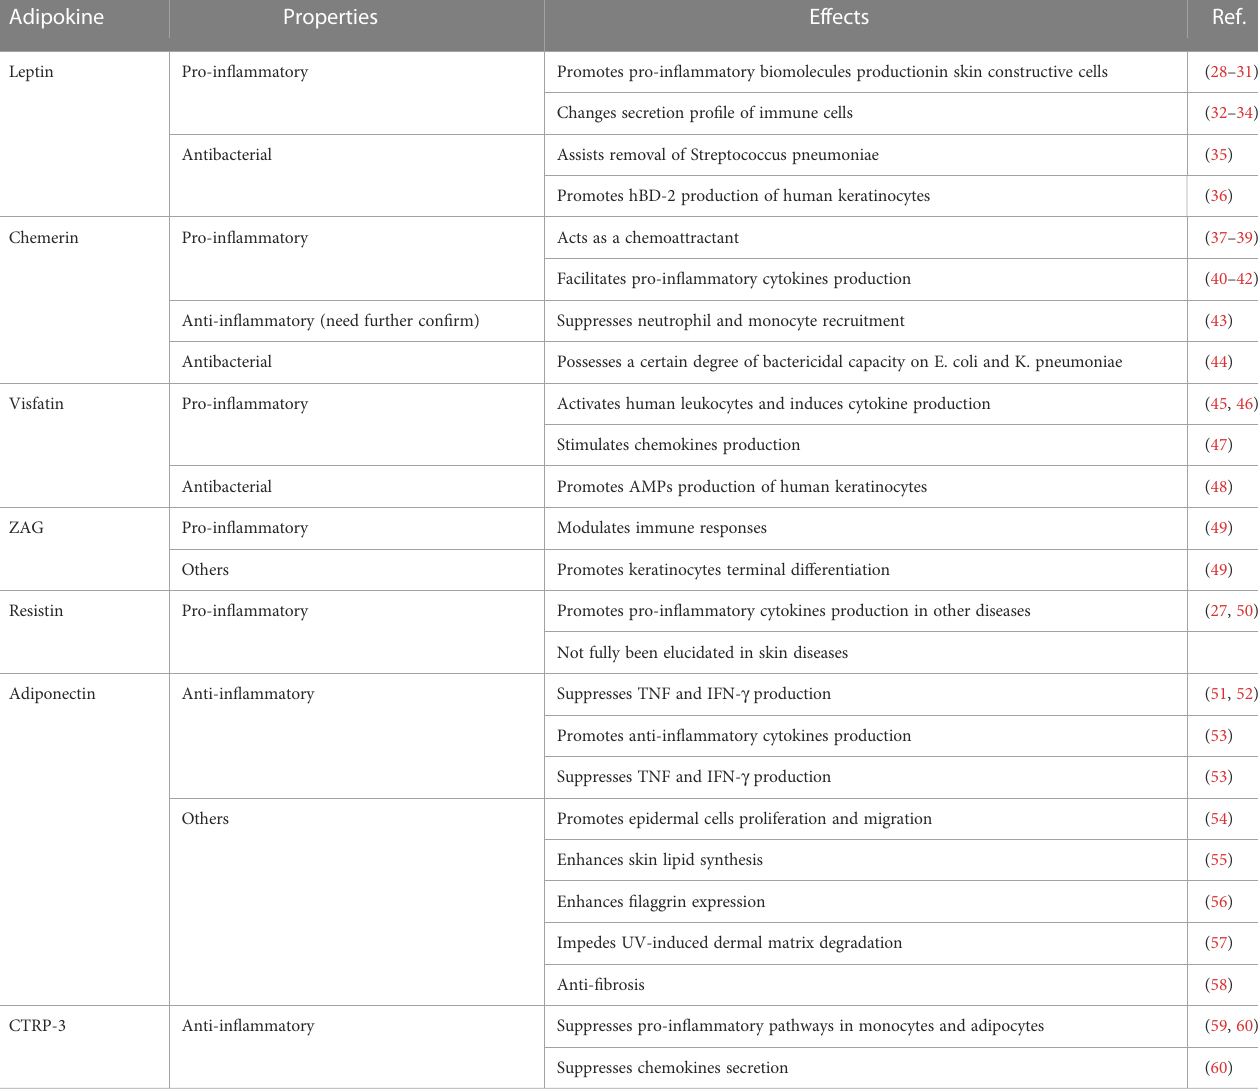
TABLE 1 Adipokines in the skin and their